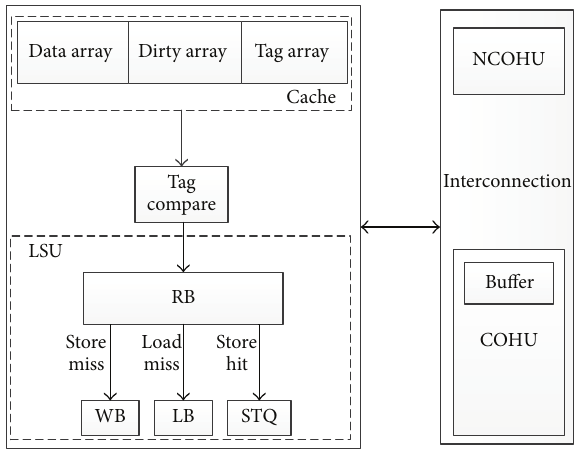
Figure 5: Block diagram of